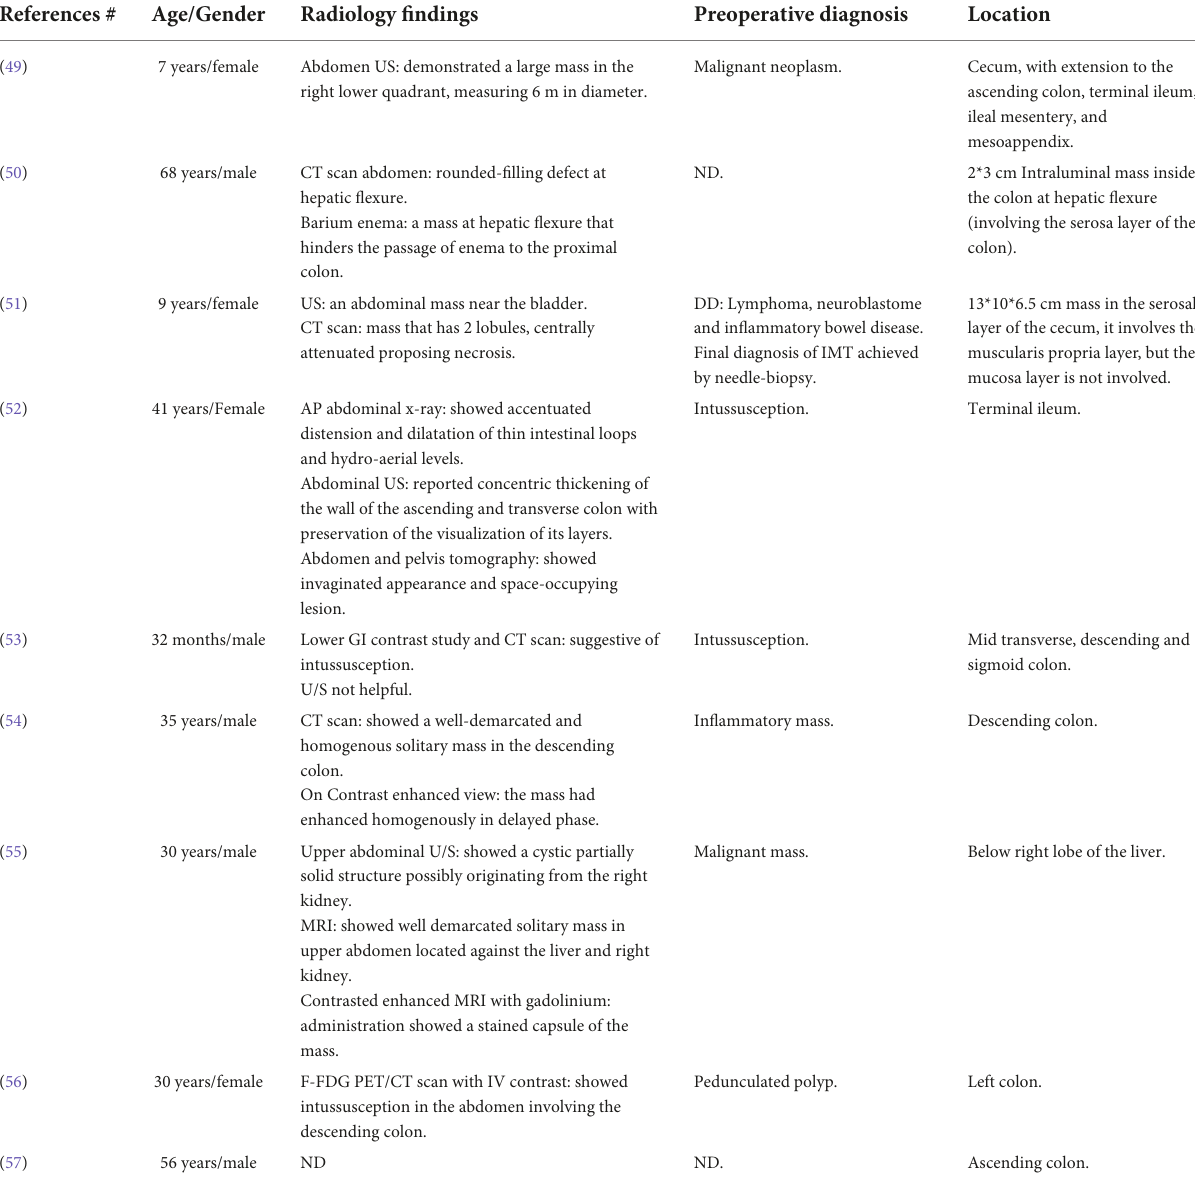
TABLE 5 Radiological features of the reported cases of inflammatory myofibroblastic tumor of the